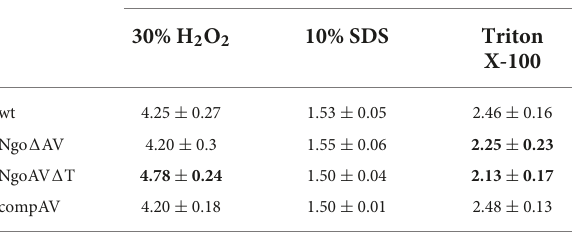
TABLE 3 Susceptibility of N. gonorrhoeae mutants within NgoAV RM system to chemicals. Diameter of inhibition zone in